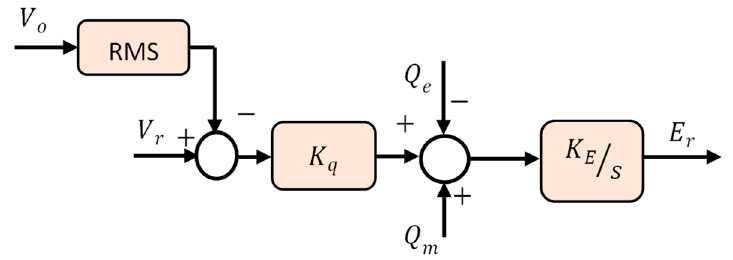
Figure 21. VSG control of voltage and frequency.